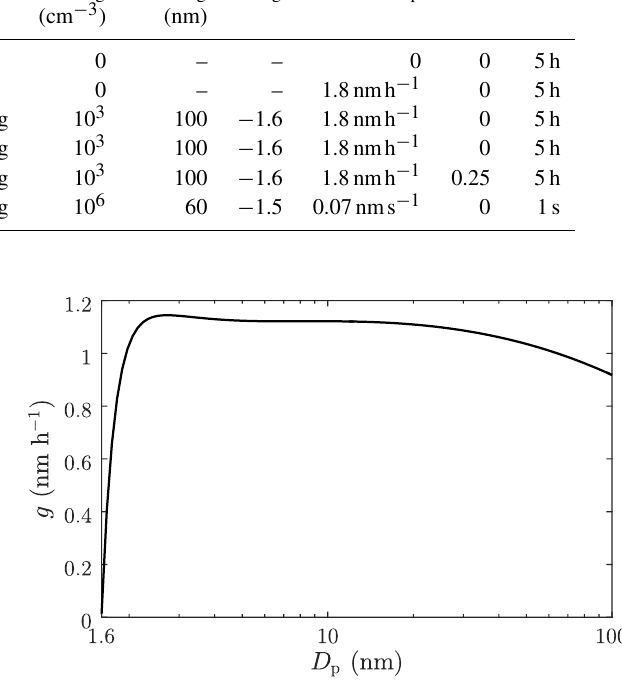
Figure 4. Size-dependent condensational growth rate of sulfuric acid-water particles with the sulfuric acid vapor concentration of 0 . 8 × 10 7 cm − 3 , temperature of 280K, and relative humidity of 60% as a function of the particle diameter, used in the Atm5